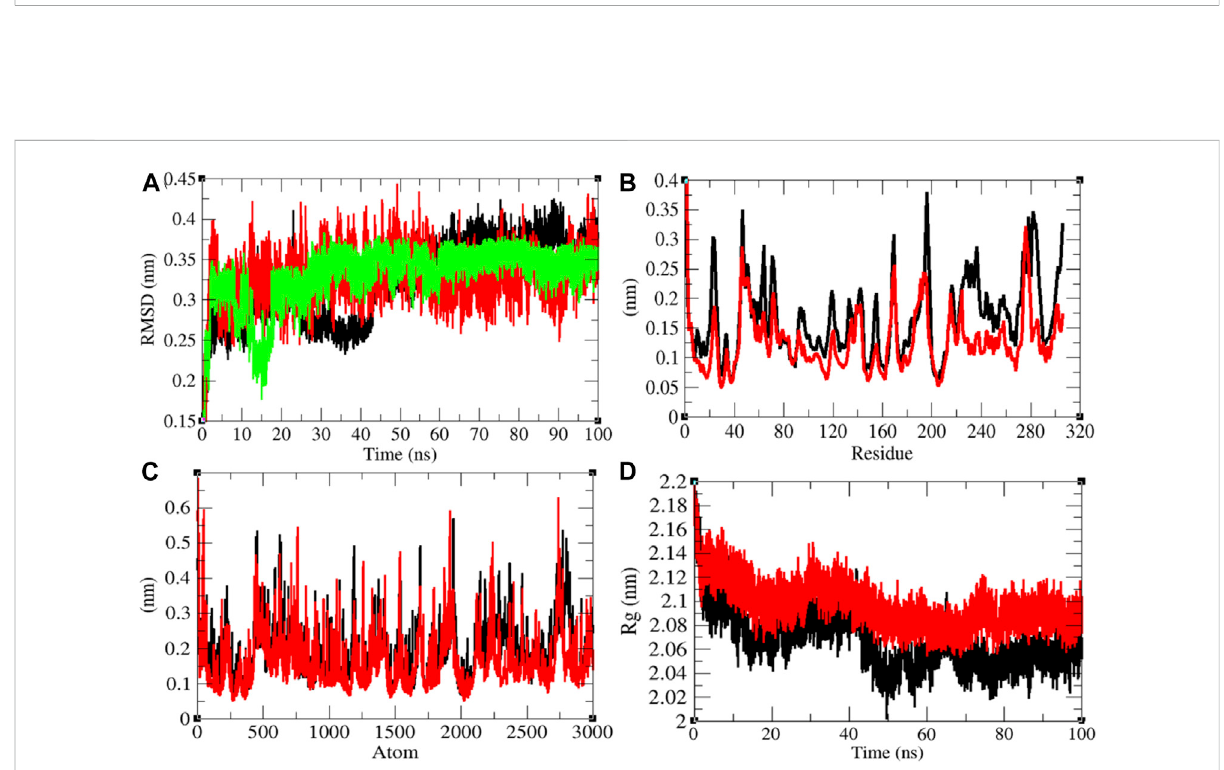
FIGURE 4 Structural dynamics of Mprotease. (A) Root mean square deviations plot for Mprotease (black), Mprotease-remdesivir (red), and remdesivir (green) as a function of time. (B) Root mean square fl uctuations vs. residues. (C) Root mean square fl uctuations vs. atoms. (D) Radius of gyration ( R g )